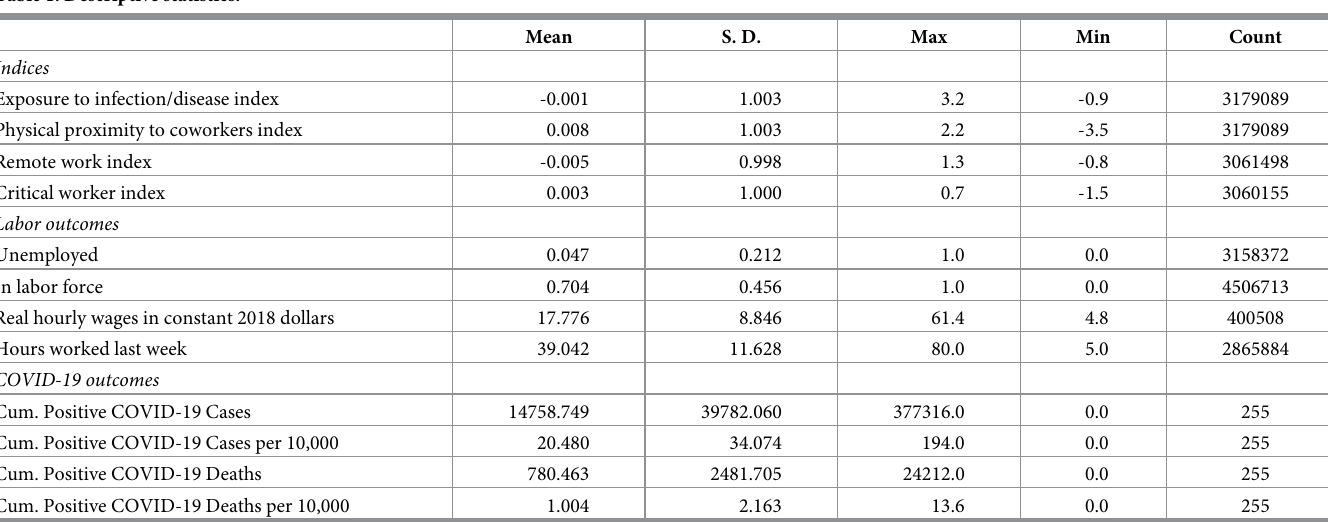
Table 1. Descriptive